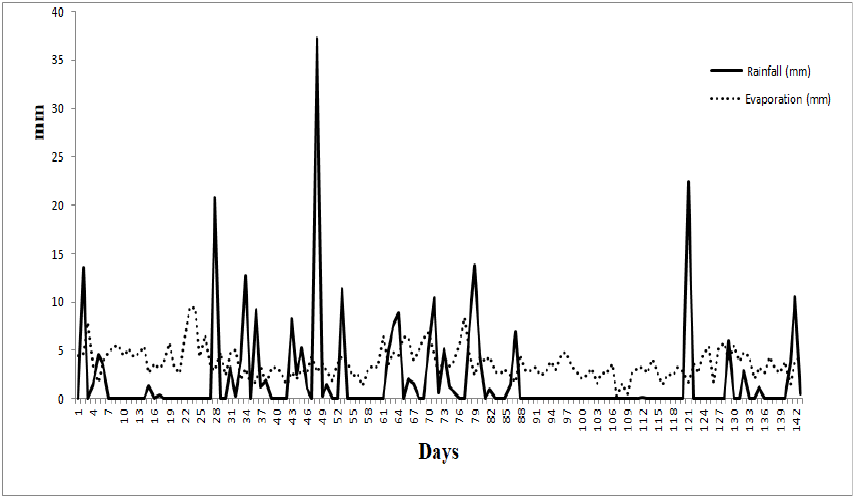
Figure 3. Evaporation and rainfall data from a Meteo Rwanda weather station in Nyagatare, Rwanda during Season B, September 2018 to January 2019.